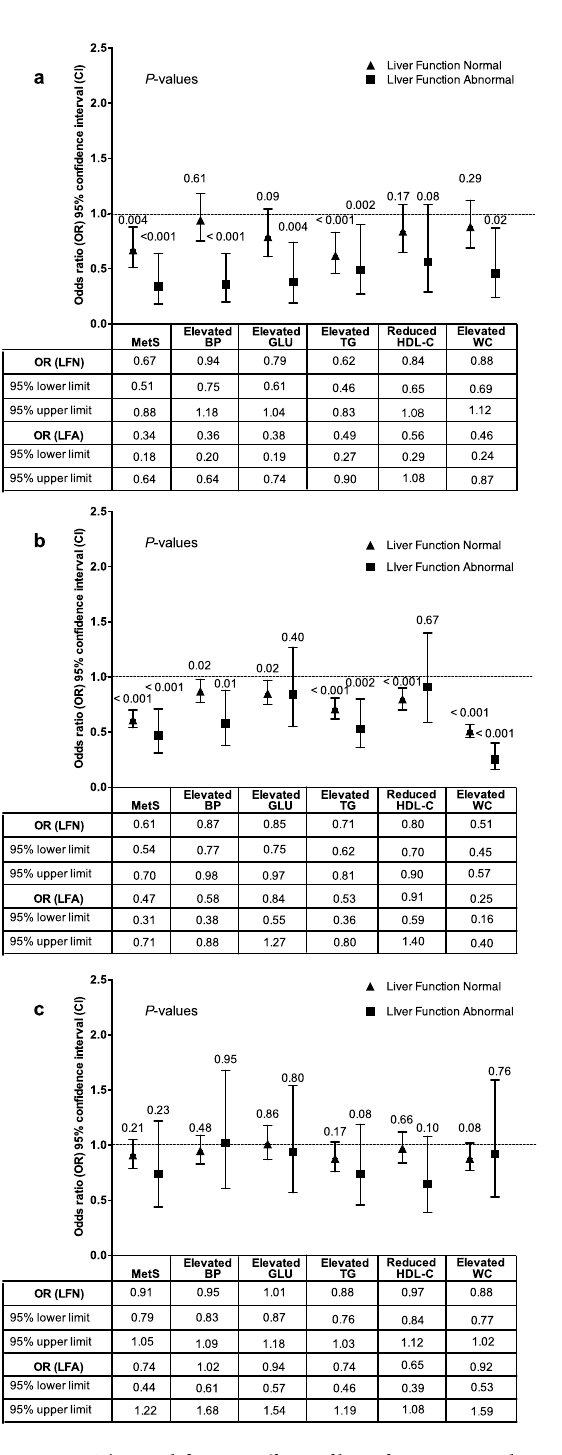
Figure 5. The modification effects of liver function on relationships of MetS and its constituents with HBV infection, Aflatoxin B1 exposure and MC-LR exposure. ( a ) The association between the liver function and HBV infection. ( b ) The association between the liver function and Aflatoxin B1 exposure. ( c ) The association between the liver function and MC-LR exposure. HBV infection and the higher AFB1 exposure (EDI) were inversely associated with MetS no matter whether the liver function was normal or abnormal. For people with HBV infection, the number of the constituents of MetS with decreased risk was higher in those showing abnormal liver function than in those showing normal liver function. For people with the higher AFB1 level, the number of the constituents of MetS with decreased risk were lower in those showing abnormal liver function than in those showing normal liver function. For people showing either normal or abnormal liver function, those exposed to the higher or lower MC-LR levels showed no difference in the risk of MetS and all its